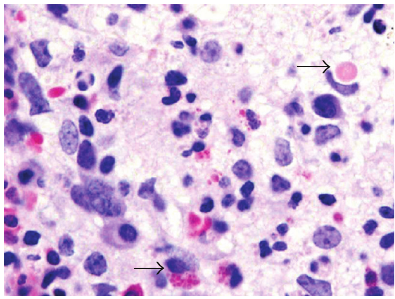
Figure 1: Wright stained bone marrow aspirate smear of the patient with Chediak-Higashi. The arrows in the upper right- hand side point to histiocytes engulfing intact red blood cells. The arrows in the lower left indicate fragmented red blood cells (hemophagocytosis).